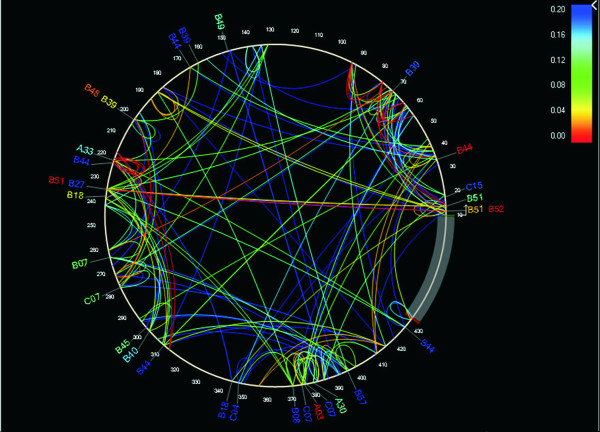
Protease and RT phylogenetic dependency network for the Mexican cohort. A phylogenetic dependency network map was generated with the PhyloDv software . Pol positions are drawn counter clockwise, with the N-terminus of the protease at the 3 o'clock position, and the first RT codon corresponding to position 100. Lines indicate associations between codons (inside the circle) or between HLA alleles and codons (outside the circle). Colors indicate q-values of the most significant associations between two attributes. Associations with q < 0.2 for 280 individuals from Central/Southern Mexico were included.